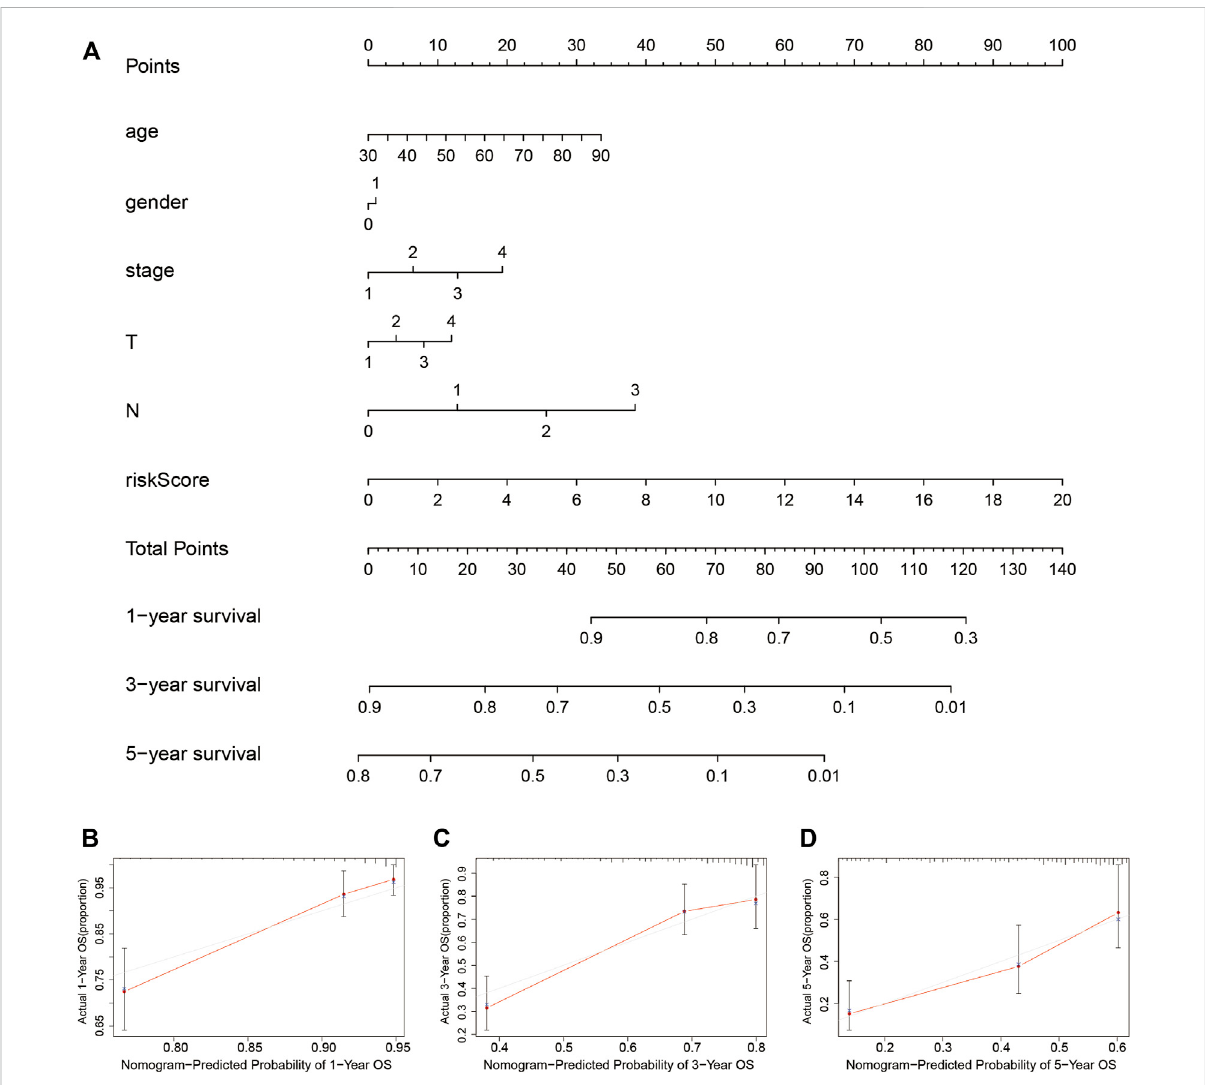
FIGURE 7 Constructionand veri fi cation ofthe nomogram (A) The nomogram combining clinicopathological variables and risk scores predicts the1-year, 3-year, and 5-year survival probability of LUAD patients. The calibration curves evaluate the consistency of predicted and actual OS at (B) 1 year (C) 3 years, and (D) 5 years. LUAD, lung adenocarcinoma; T, tumor; N, lymph node metastasis; M, distant metastasis; OS, overall